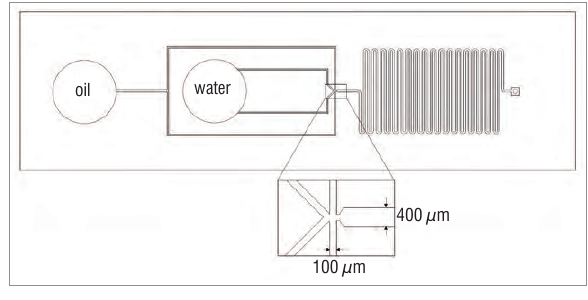
Figure 8: Design of the droplet-generation device used to generate droplets on the centrifugal microfluidic platform. The PDMS devices were mounted to the PMMA disc with the reservoirs filled with mineral oil (with surfactant 3% by weight of Span 80) and deionised water with blue dye and observed at varying rotational speeds. At approximately 550 rpm, monodisperse water droplets in an oil phase were produced with high stability (Figure 9).